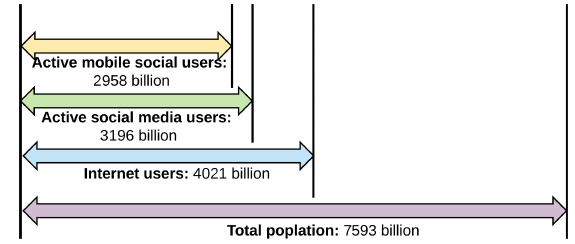
Fig. 2 Number of social media users in the